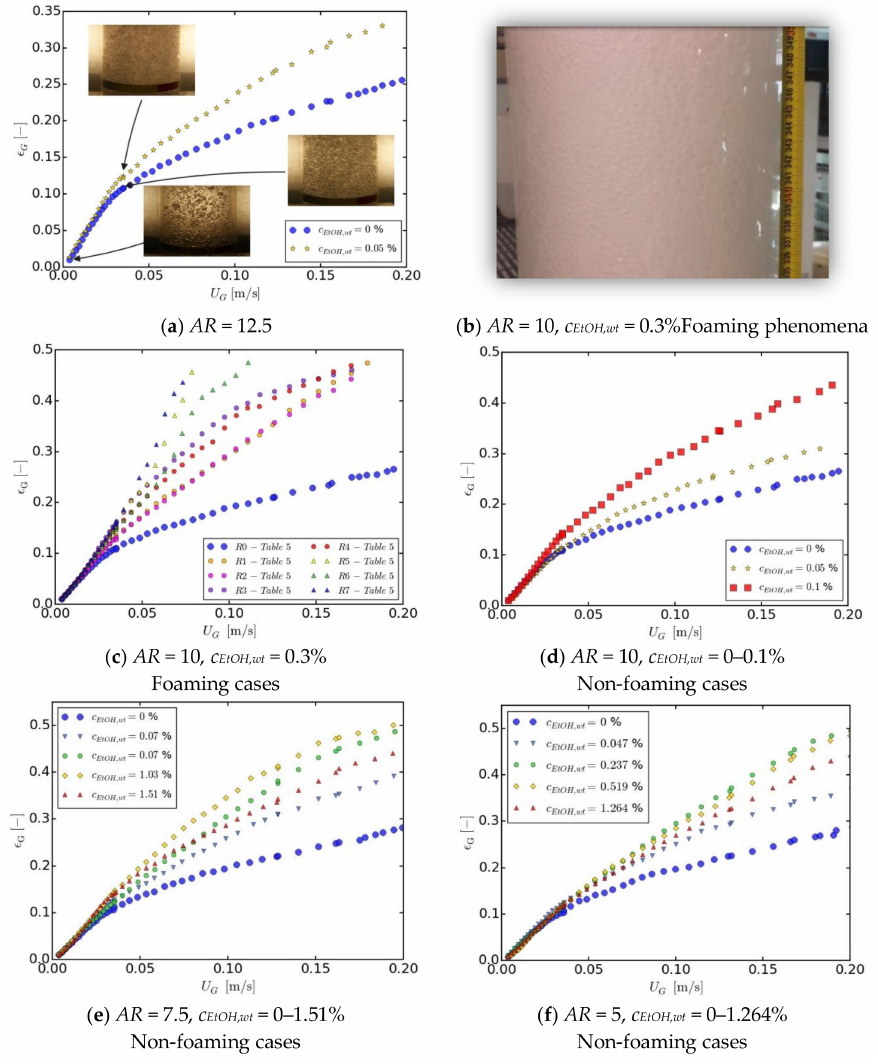
Figure 24. Influence of EtOH on gas hold-up—data from ref. [12]. Table 3. References codes for Figure 24